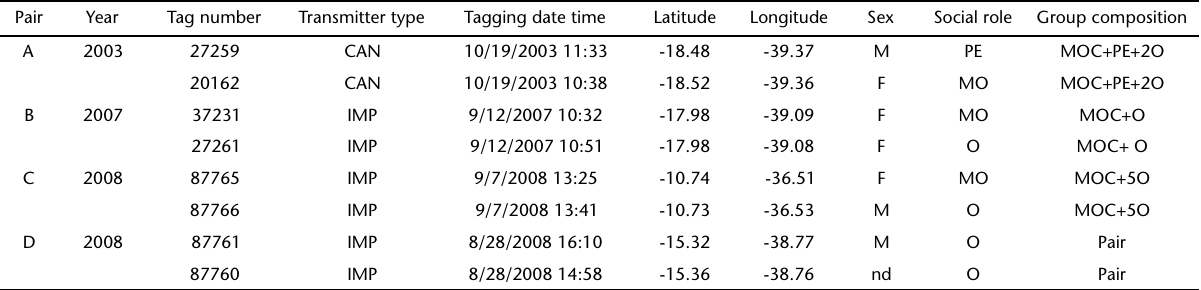
Table I. Spatial and temporal data for humpback whale pairs A, B, C and D tagged on the Brazilian breeding grounds between 2003 and 2008. Year, tag number, transmitter type, sex, social role, group composition at the moment of deployment is presented for each pair. Pair